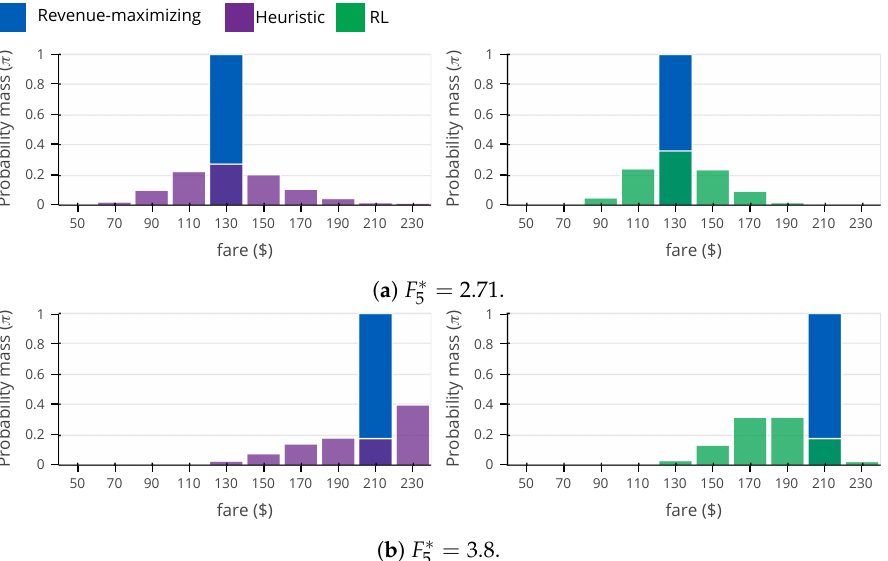
Figure 8. Comparison between heuristic and reinforcement learning (RL) roll-out policies. For convenience, we represent the revenue-maximizing